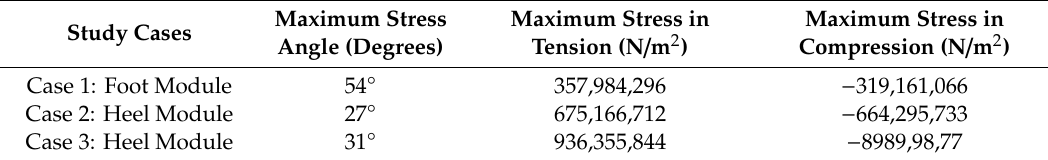
Table 2. Comparison of maximum stresses.